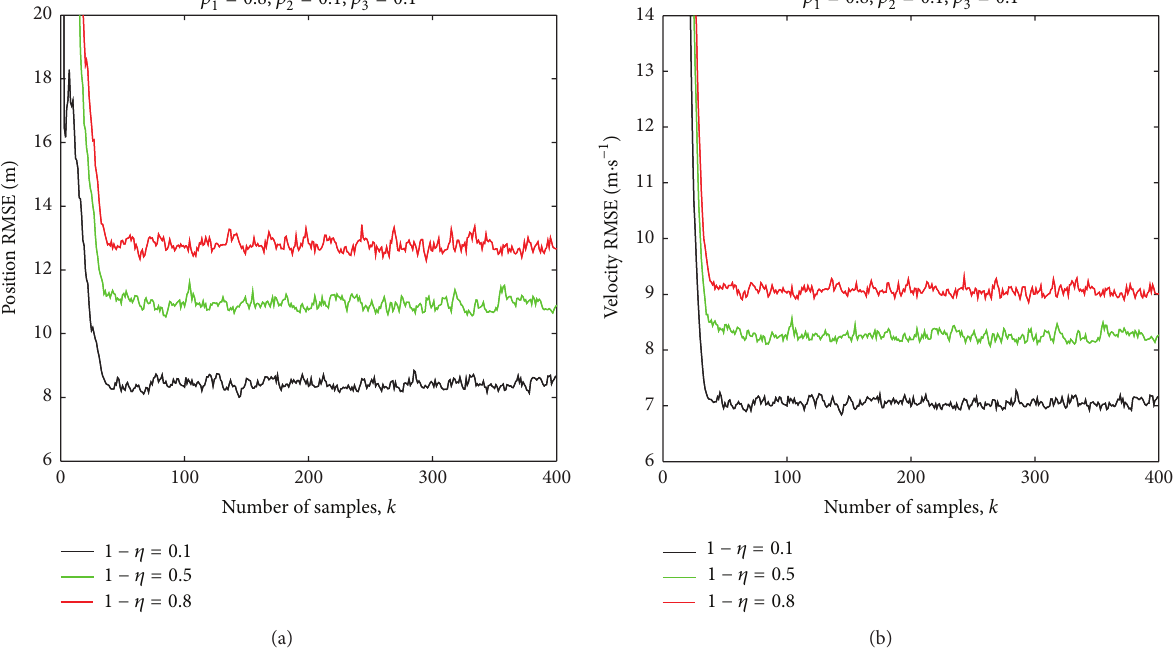
by detection probability, one-step delay probability, missing probability, and stochastic-bias probability. Moreover, we have the corresponding results in scenarios B and C as well as in scenario